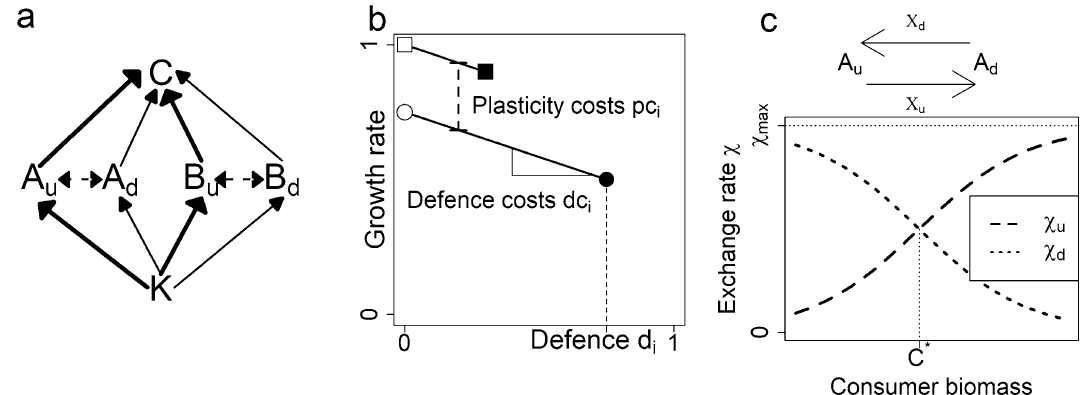
Figure 1. Food web structure, trade-offs, and exchange rates. ( a ) Food web of two plastic, autotrophic species A and B sharing a carrying capacity K and a consumer C . Both autotrophic species have an undefended, u, and a defended, d, phenotype. Solid arrows represent biomass fluxes and their widths indicate their relative importances. Dotted arrows indicate plastic exchange between phenotypes. ( b ) Trait space of defence and growth rate, showing how trade-offs are shaped by three key properties: level of defence d i , plasticity costs pc i and defence costs dc i . White symbols denote the undefended phenotypes of a hypothetical species, black symbols the defended phenotypes of the same species. Solid lines link phenotypes of the same species. ( c ) Exchange rate χ between both phenotypes and its dependence on the consumer biomass (see Eqs. 9, 10 in